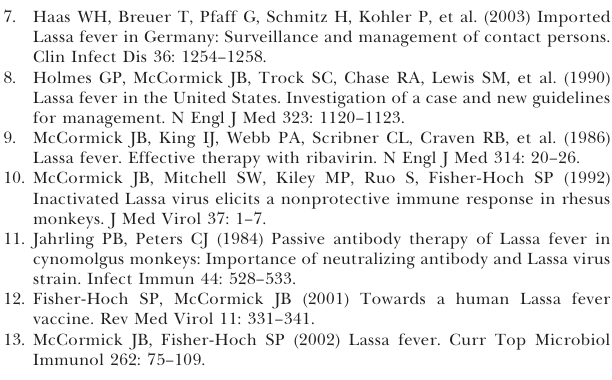
Figure S3 (rLCMV/INDG-Induced Immune Protection Is Rapidly Established), Figure S4 (Rapid and Potent nAb Response to rLCMV/ NJG Infection), Figure S6 (Generation and Molecular Character- ization of rLCMV-ARM*), and Figure S7 (Indistinguishable CTL Response to LCMV-ARM and rLCMV-ARM* Infection), with supple- mentary references and supplementary methods. Table S1. Serological Characterization of Wild-Type and Recombi- nant LCM Viruses Found at DOI: 10.1371/journal.ppat.0020051.st001 (36 KB